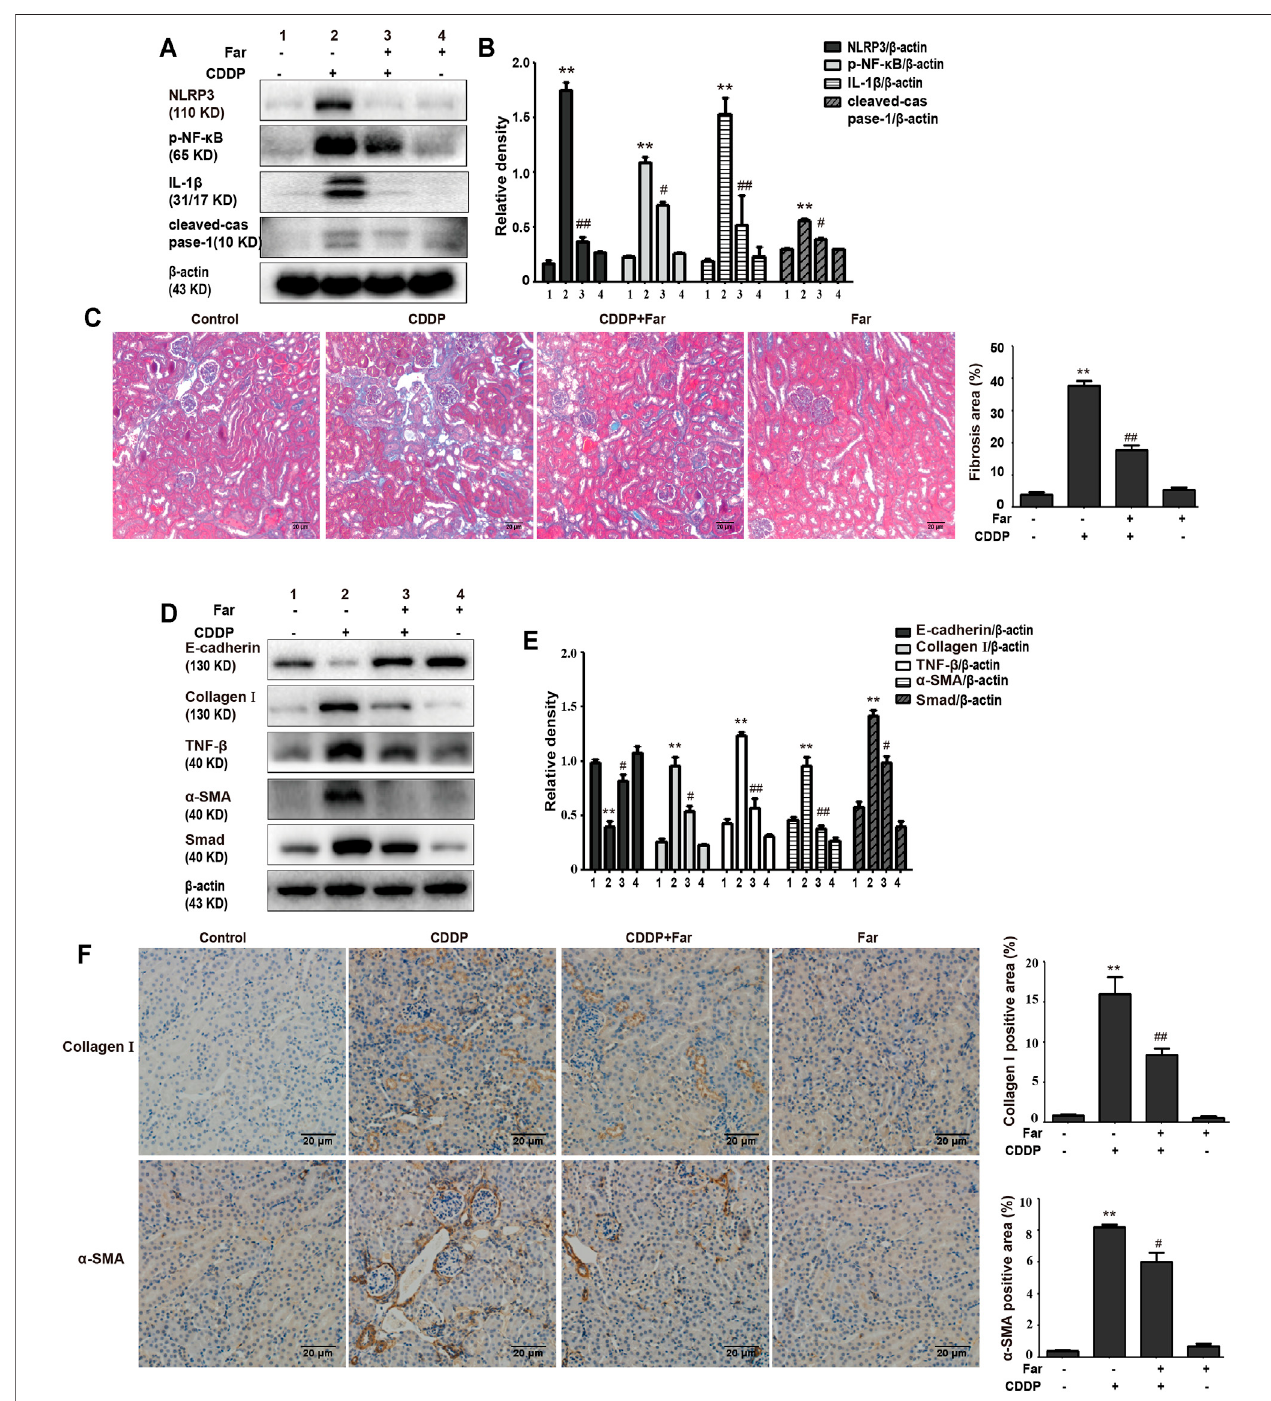
FIGURE2| Farrerolameliorates cisplatin-induced in fl ammation and kidney fi brosis inmice.The protein levels ofp-NF- κ B, NLRP3,cleaved caspase-1 and IL-1 β in C57BL/6 mice were investigated by western blotting (A) and analyzed by densitometry analysis (B) . (C) Masson staining of renal sections and quantitative analysis of fi brosisareainthekidneytissue.WesternblottingimagesofTGF- β ,E-cadherinandthe fi brosis-relatedproteinsSmad,collagenIand α -SMAinthekidneyareshown (D) and evaluated (E) . (F) Immunohistochemical analysis of collagen I and α -SMA (control n (cid:1) 6, farrerol n (cid:1) 6, cisplatin n (cid:1) 6, and CDDP + farrerol (cid:1) 6). A quantitative analysisofcollagenIand α -SMApositiveareainthekidneytissue.Dataareshownasmean ± SEM.Allexperimentswereperformedthreetimes.* p < 0.05and** p < 0.01 vs. the control group; # p < 0.05 and ## p < 0.01 vs. the CDDP group. β -actin was used as an internal control.